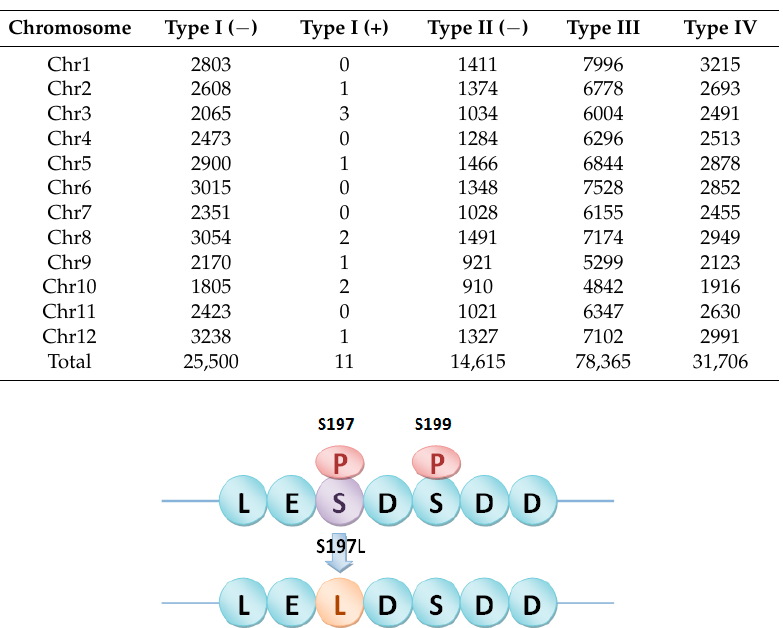
Table 2. Different phosSNPs on different chromosomes in rice genome 7.0.